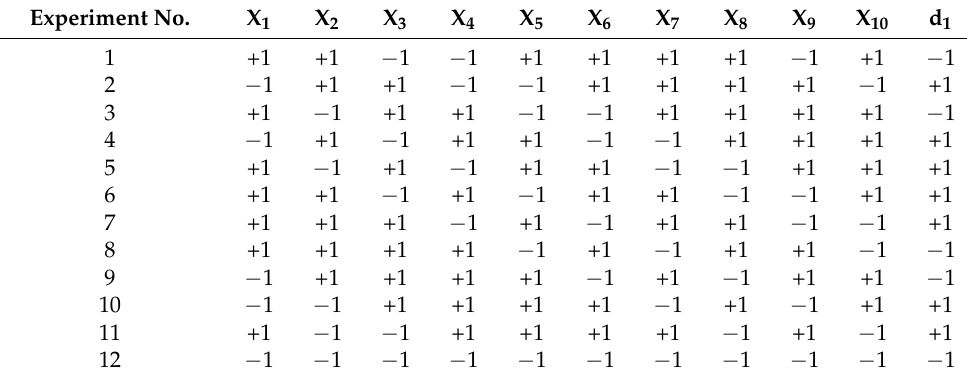
Table 4. The Plackett–Burman design of the experiments. Experiment No.